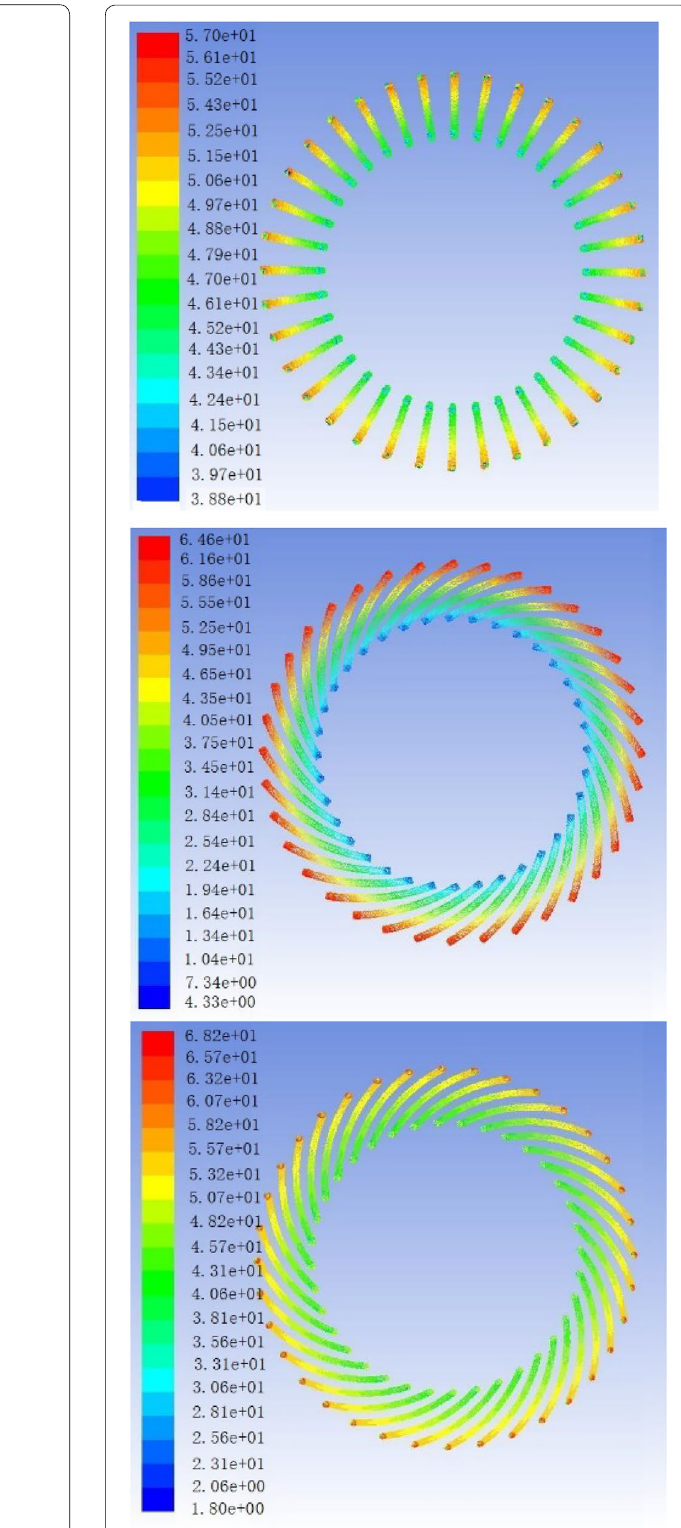
Figure 7 Velocity vector diagram of different channels